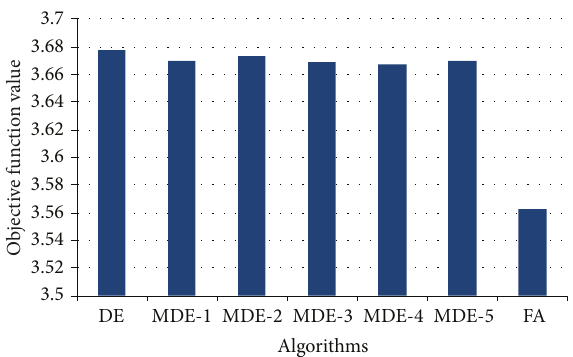
Figure 3: Best results obtained, for the IEEE 4-bus model, by different techniques are compared with the firefly